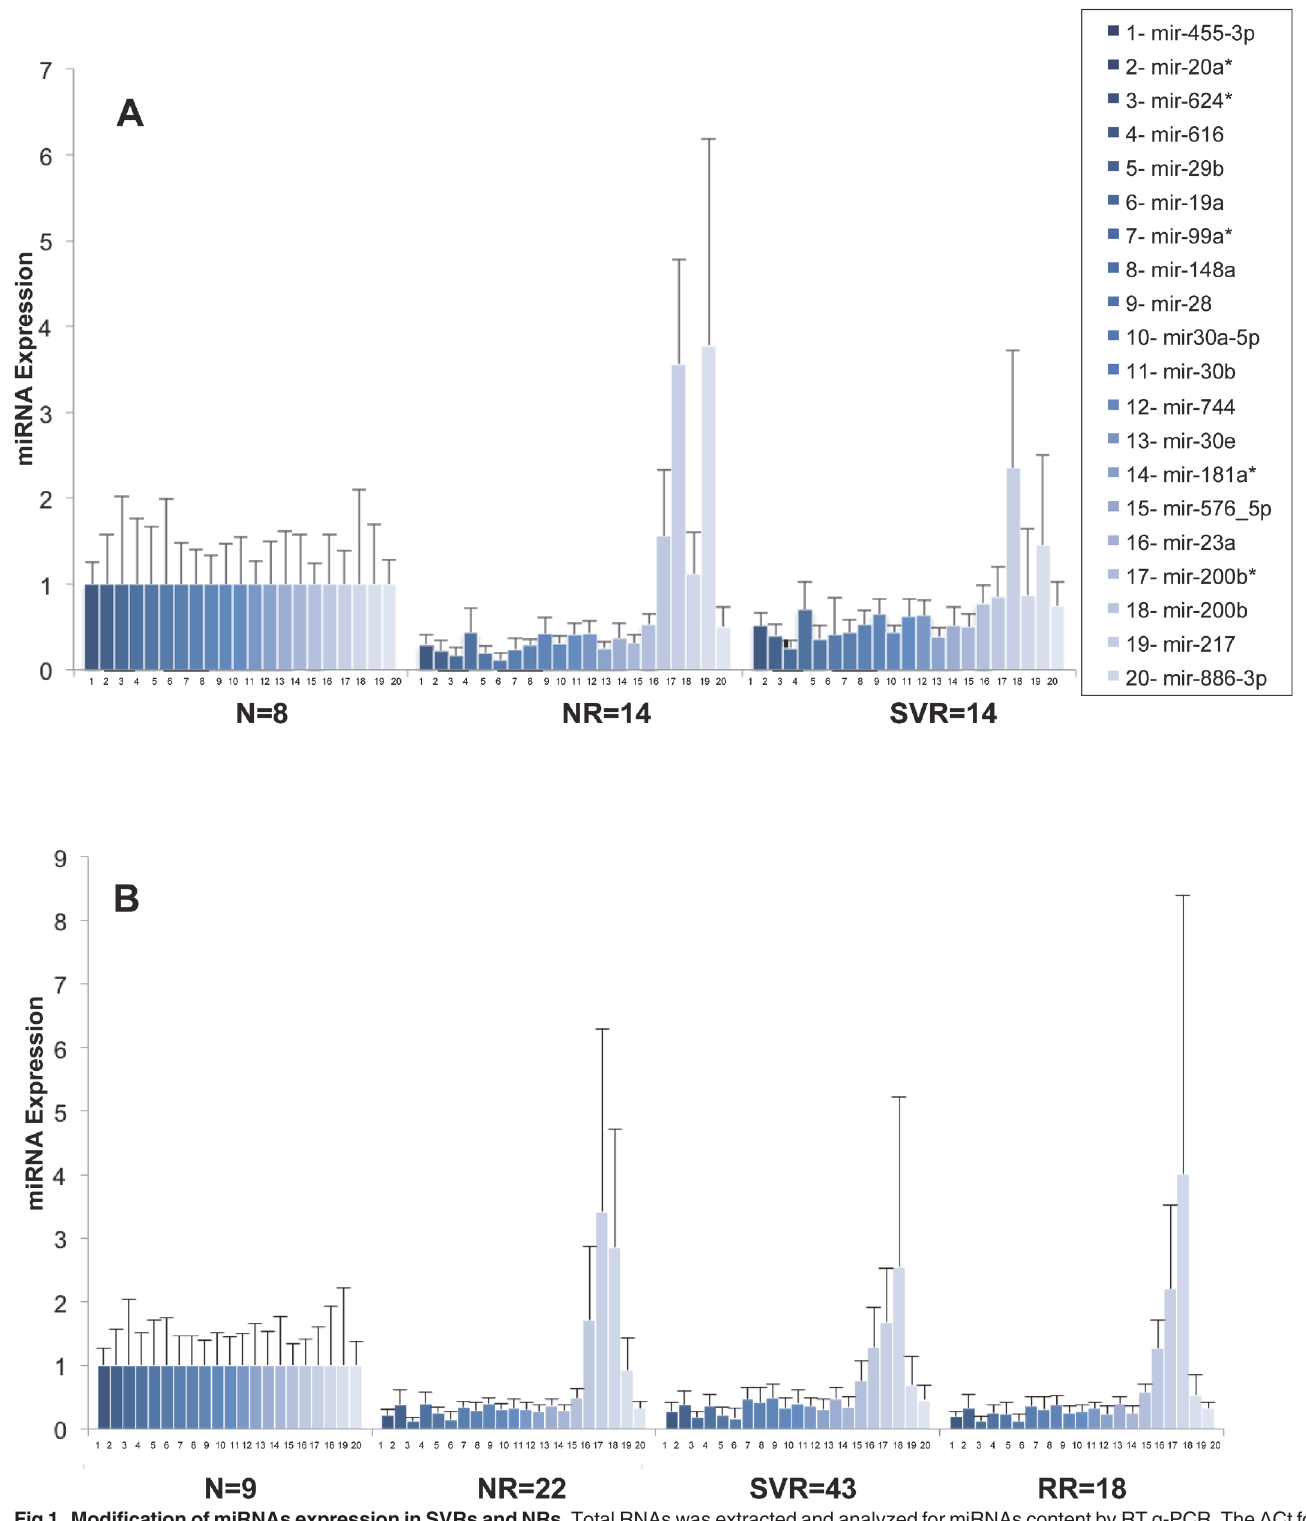
Fig 1. Modification of miRNAs expression in SVRs and NRs. Total RNAs was extracted and analyzed for miRNAs content by RT q-PCR. The Δ Ct for each miRNA was calculated and normalized to the Δ Ct value of SNORD44, in each biopsy. The histograms represent the mean expression of miRNAs/ SNORD44 within the groups of patients NRs, SVRs and RRs normalized to the expression of the same miRNA within the group of normal patients. The